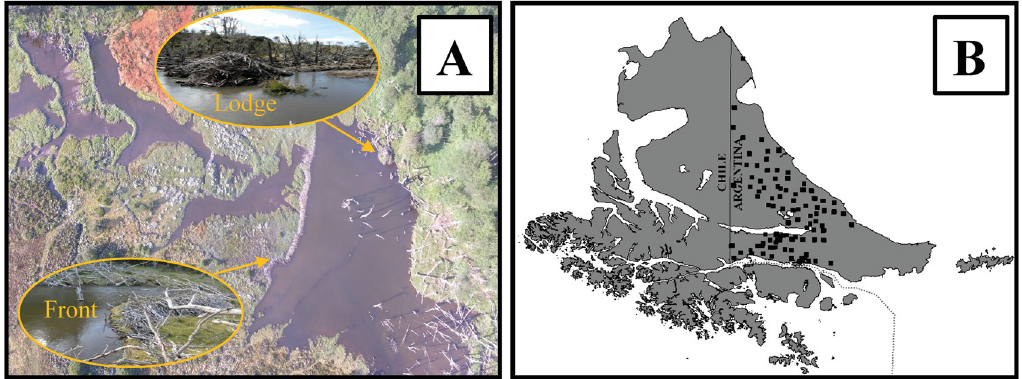
Fig 2. Remotely sensed beaver dam data. (A) Example of the analyzed beaver dams (photo by A. Huertas Herrera). (B) Verification plot (black quadrants) distribution in the Argentine portion of Tierra del Fuego.